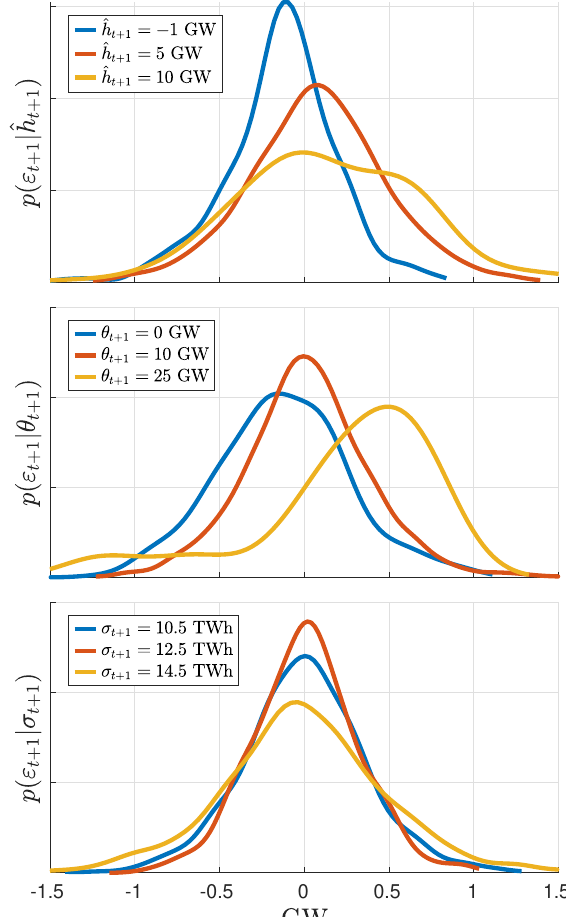
Figure 2. Statistical distribution of ε t + 1 conditioned to three levels of: ( top ) predicted hydropower generation, ˆ h t + 1 ; ( middle ) thermal gap, θ t + 1 ; ( bottom ) reservoir filling level, σ t + 1